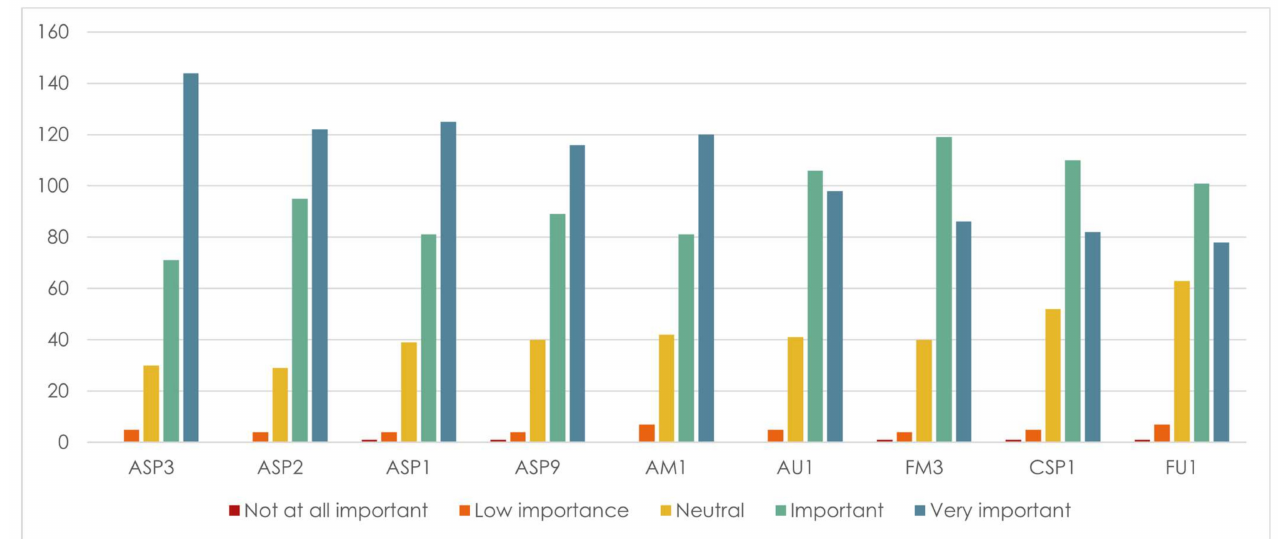
Figure 1. Perceived importance of creating an automated residential environment.